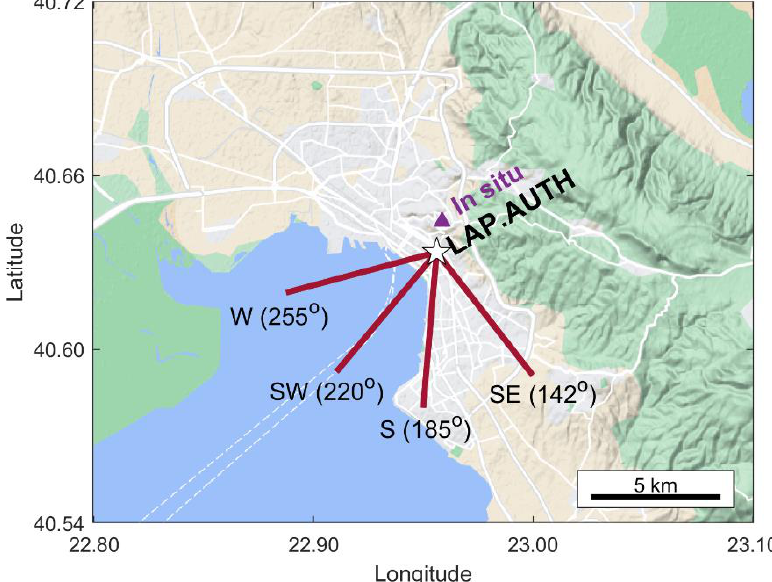
Figure 1. The locations of the MAX-DOAS instrument (white star) and the in situ NO 2 measurement site (purple triangle). The four different azimuth viewing directions of the MAX-DOAS observations are represented by the solid red lines. The base map is taken from © Google Maps, https://www.google.com/maps, accessed on 20 January 2023.